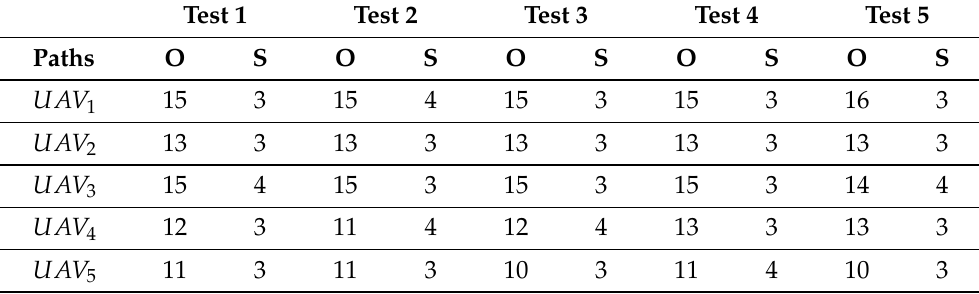
Figure 9. Example of 3D path smoothing. Table 2. Comparison of waypoints entered in the original paths and smoothed in 3D for each swarm